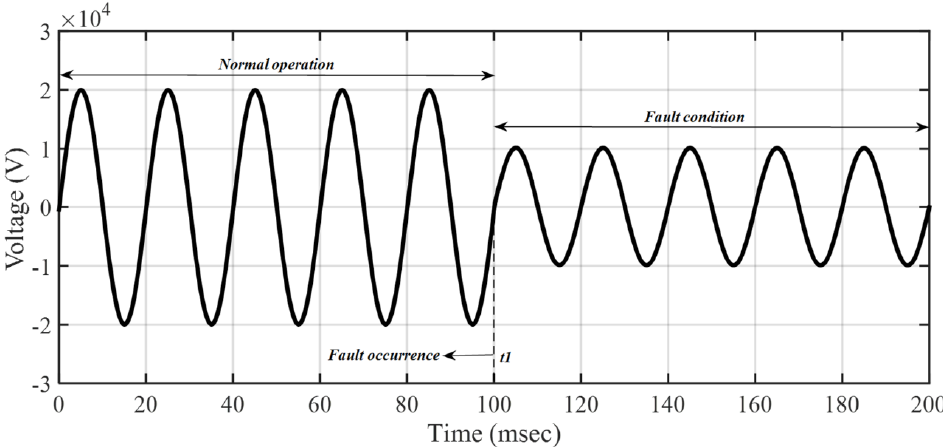
Figure 5. System voltage and current without HBFCL effect—the point of common coupling (PCC) voltage during normal and fault conditions.